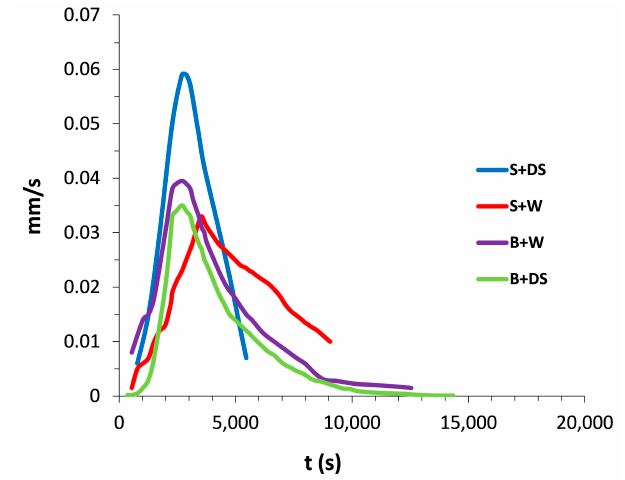
Figure 17. Interface displacement velocity between the two-phase and saturated zones.